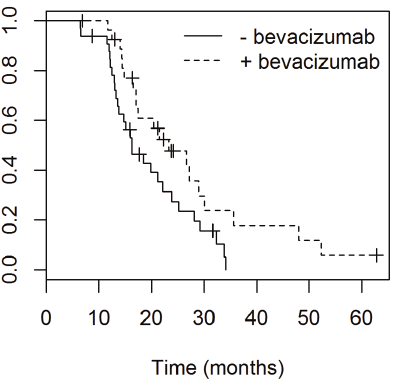
Figure 3. Overall survival of patients who received bevacizu- mab after progression compared to those who didn’t. Patients receiving bevacizumab had a median OS of 23.3 months (95% CI: 17.1– 35.6), compared to 16.3 months (95% CI: 13.8–25.1) in patients who did not receive it, P=0.0284.